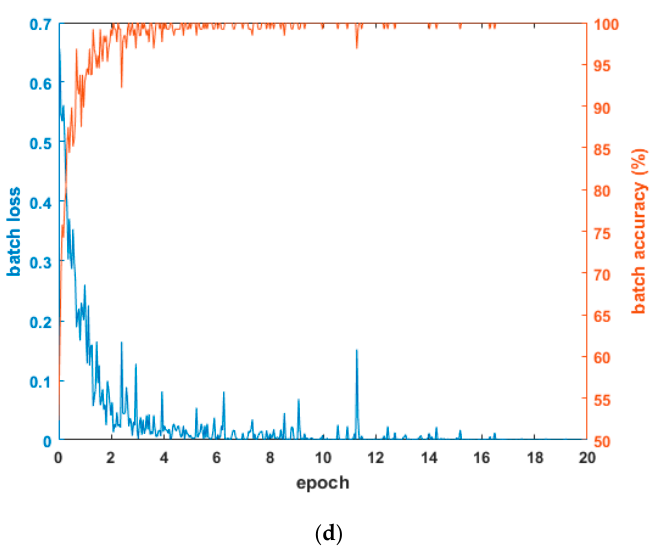
Figure 4. Examples of loss and accuracy curves with training data of four-fold cross validation in case of using combined database images: ( a ) 1st fold; ( b ) 2nd fold; ( c ) 3rd fold; and ( d ) 4th fold.